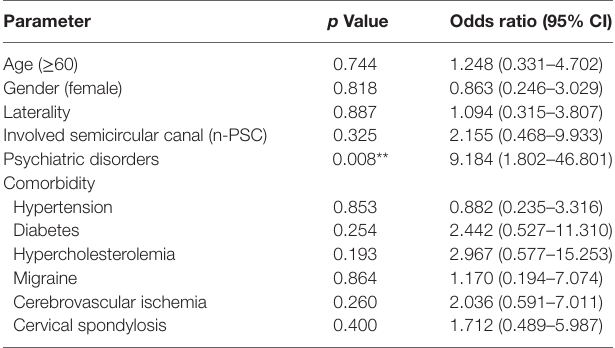
TaBle 4 | Logistical regression analysis of recurrence of BPPV within 6 months.